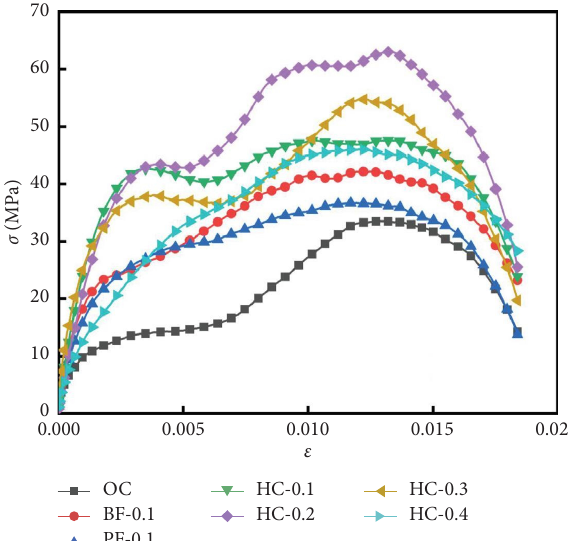
Figure 11: Stress-strain curve of the dynamic compression test.